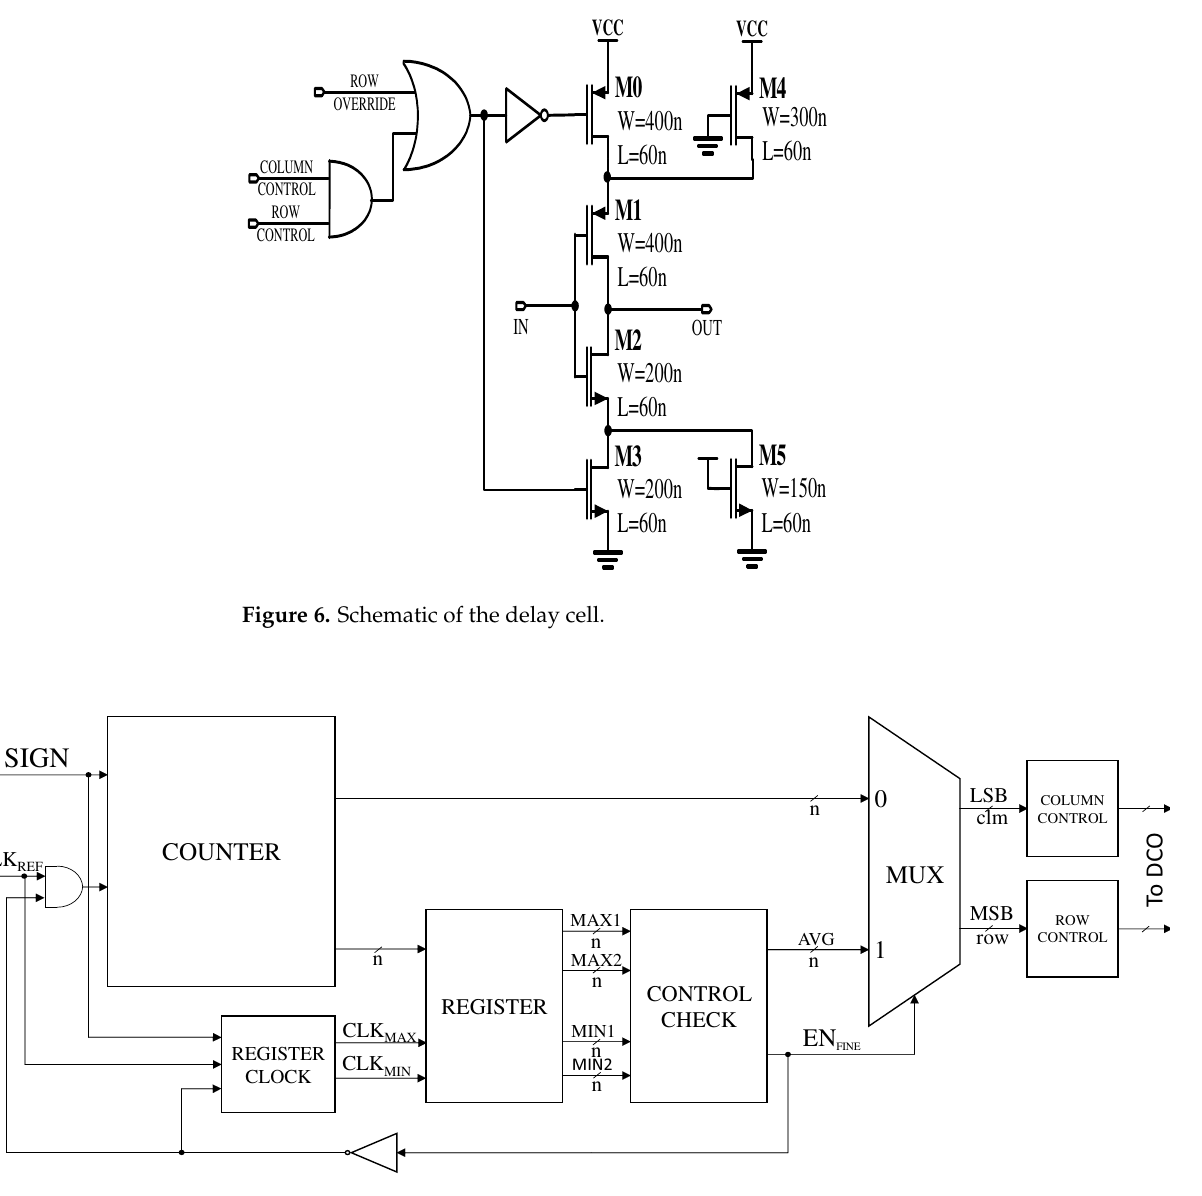
Figure 7. Block diagram of the